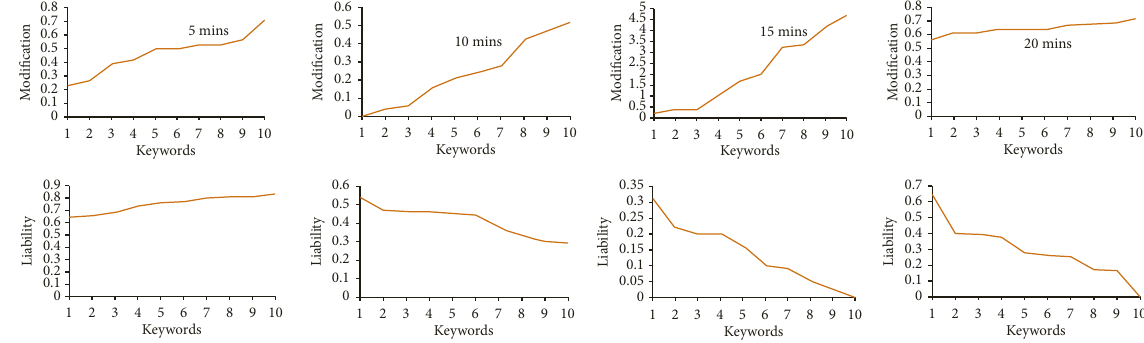
Figure 6: Modification and liability for keywords. D r for M